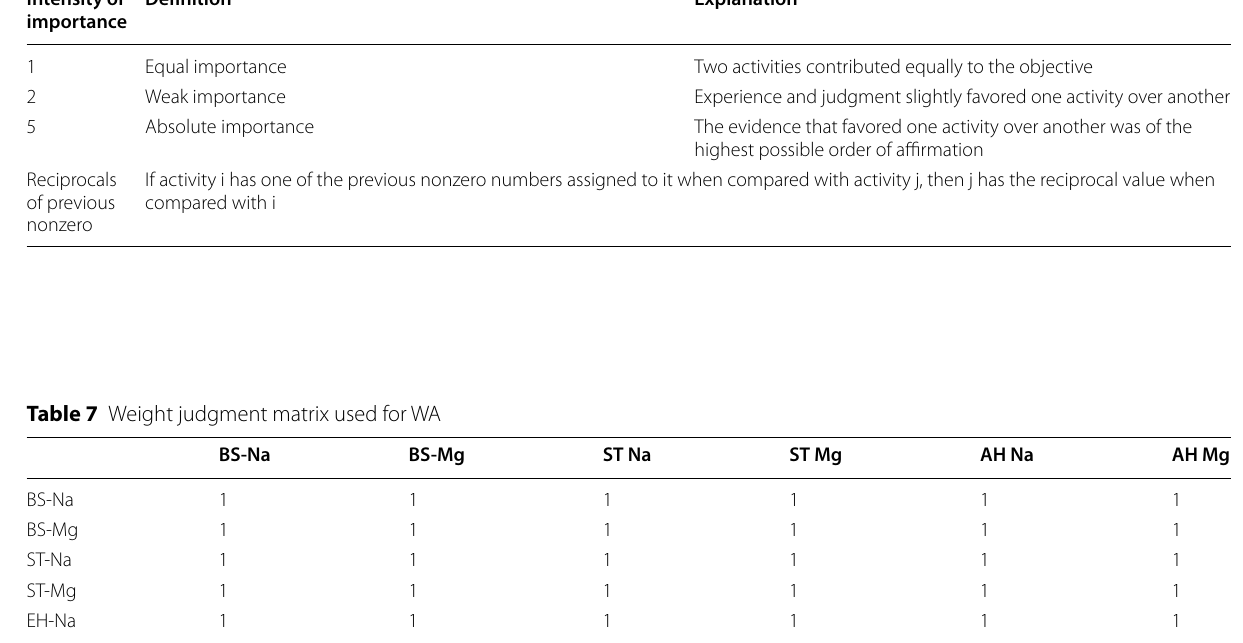
Table 6 Summary of pairwise comparison values Intensity of Definition importance